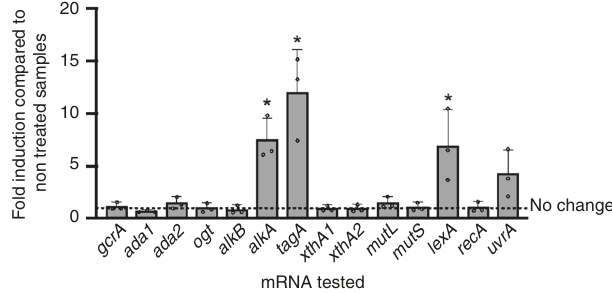
Fig. 5 Gene expression following MMS treatment. RT-qPCR was performed on exponential phase B. abortus cultured in rich medium for 5 h in the presence or absence of 2.5 mM MMS. Experiments were performed three times and mean values were compared between the stressed and non- stressed conditions. Error bars represent standard deviation. Student ’ s t- test was performed on data with minimum 1.5-fold induction ( p < 0.05, *). Source data are provided as a Source Data fi